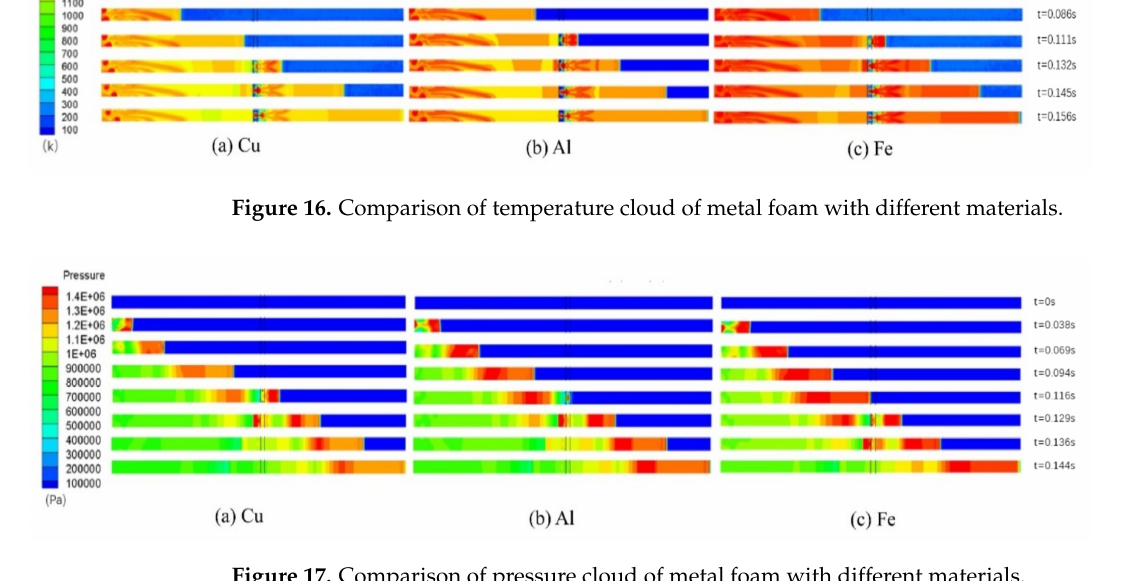
Figure 17. Comparison of pressure cloud of metal foam with different materials.